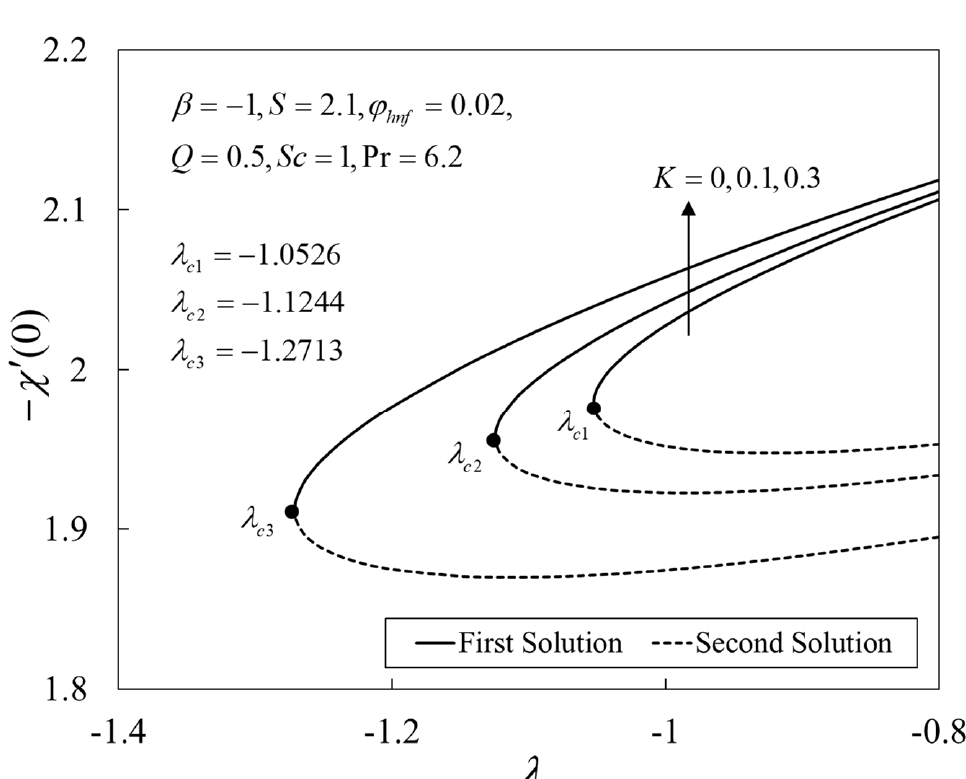
(cid:48) ( 0 ) against λ .